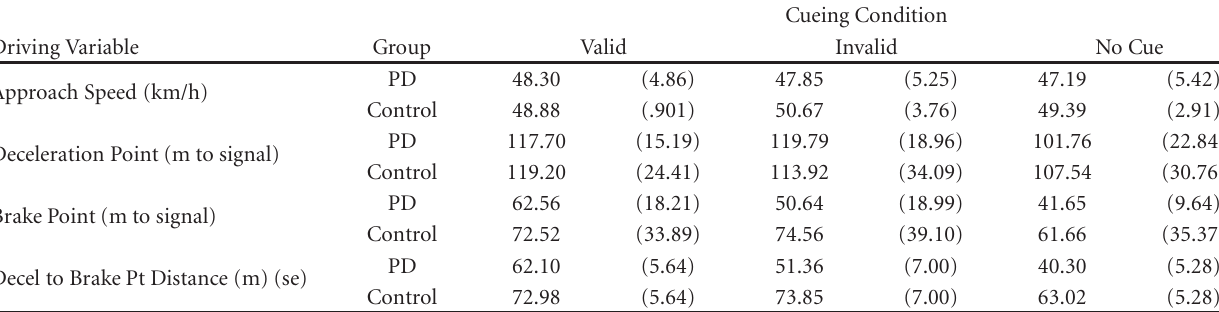
Table 2: Red tra ffi c signal means (and SDs) of driving variables for each group across the three cueing